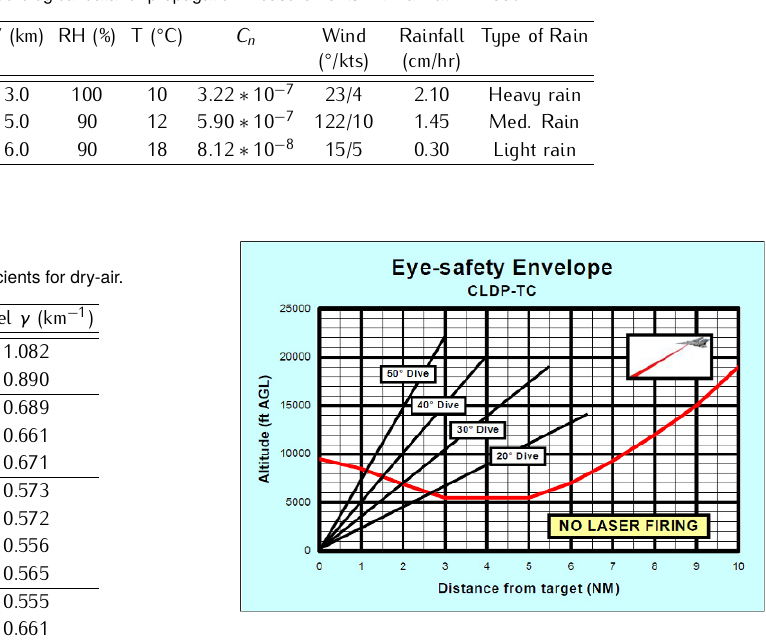
Figure 12. CLDP-IR eye-safety